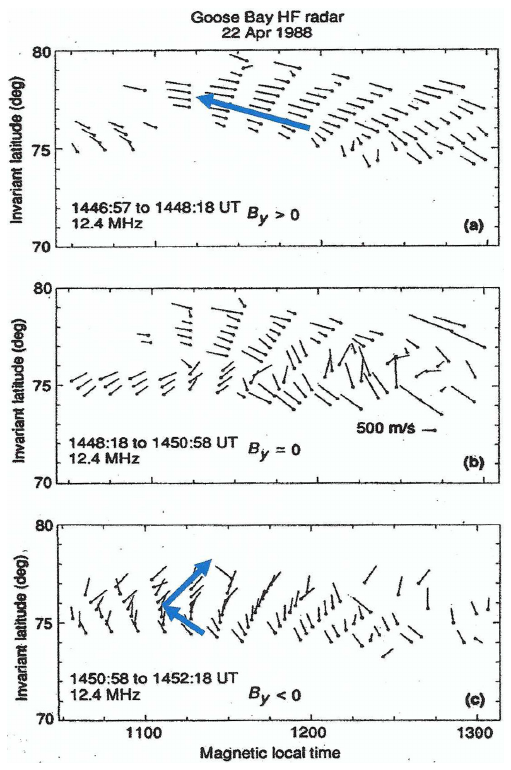
Figure 10. This figure displays how a single HF radar can track the convection dynamics that are associated with a transition in IMF B y from positive to negative. Panel (a) shows the plasma convection in the vicinity of the cusp just prior to the B y transition. Most vectors are directed toward the northwest. Panel (b) shows the data obtained by averaging the next two scans. At the highest latitudes, there is still evidence of the B y positive state, while, at lower latitudes, a new pattern is forming. Finally, in panel (c) , a fully formed B y - negative convection pattern is seen. Blue arrows have been inserted to help the eye. Adapted from Fig. 9 of Greenwald et al.